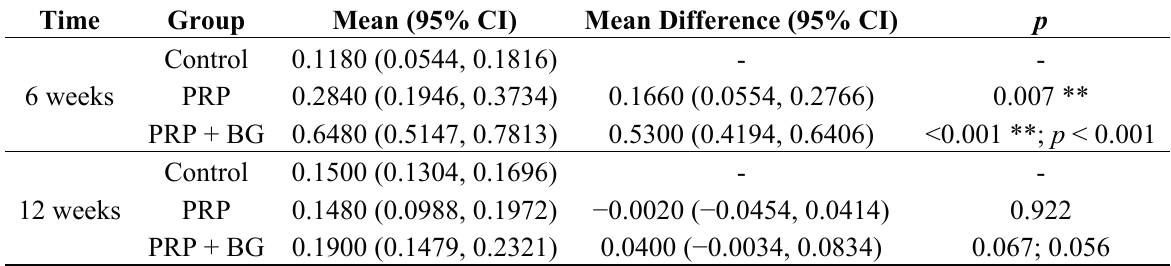
Table 3. Multiple comparisons of mRNA levels of BMP-2 among groups at different time